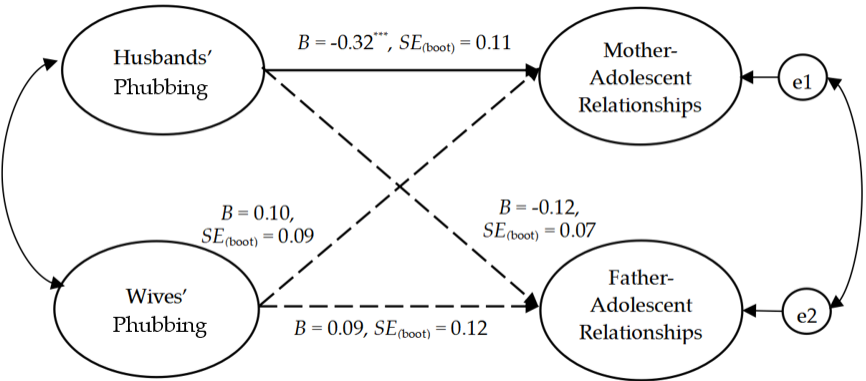
Figure 3. The dyadic model of the whole participants in the girl sample. Note. N = 192 couples. *** p < 0.001. Dotted line indicates non-significant.